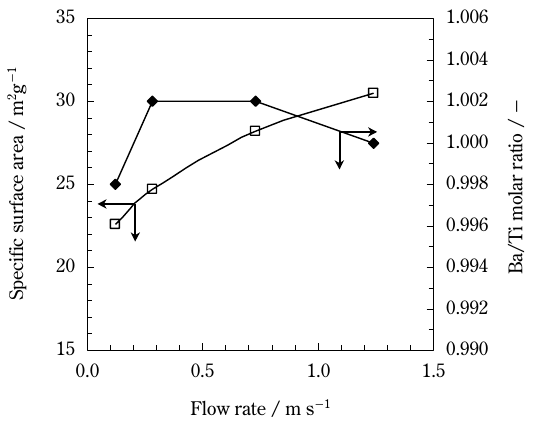
Effect of mixing condition on the specific surface area and the Ba/Ti molar ratio of BaTiO 3 particles prepared by sol- gel method.